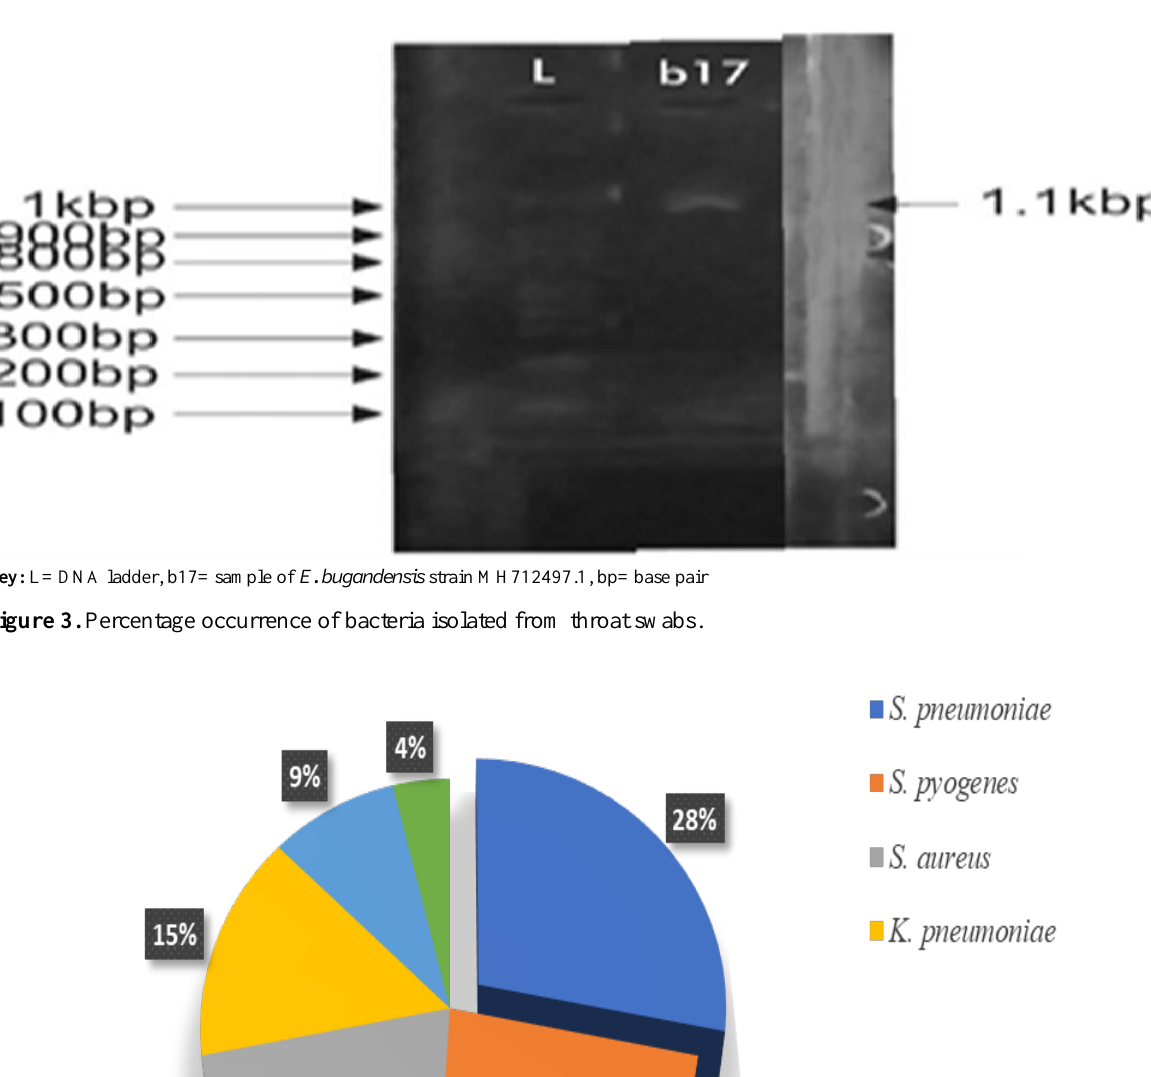
Figure 2. Gel electrophoresis picture of 16S rRNA gene amplification of Enterobacter bugandensis strain MH712497.1 with amplicon size of 1kbp.